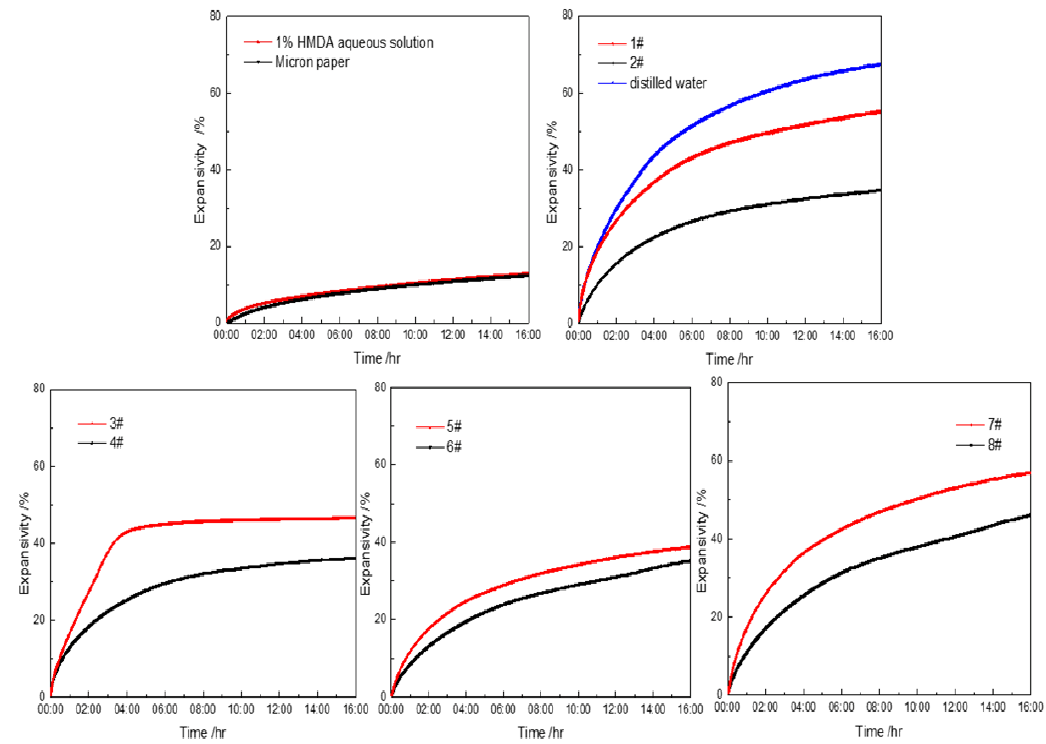
Figure 7. Effect of different mud cakes on the inhibition of HMDA. Figure 7. E ff ect of di ff erent mud cakes on the inhibition of